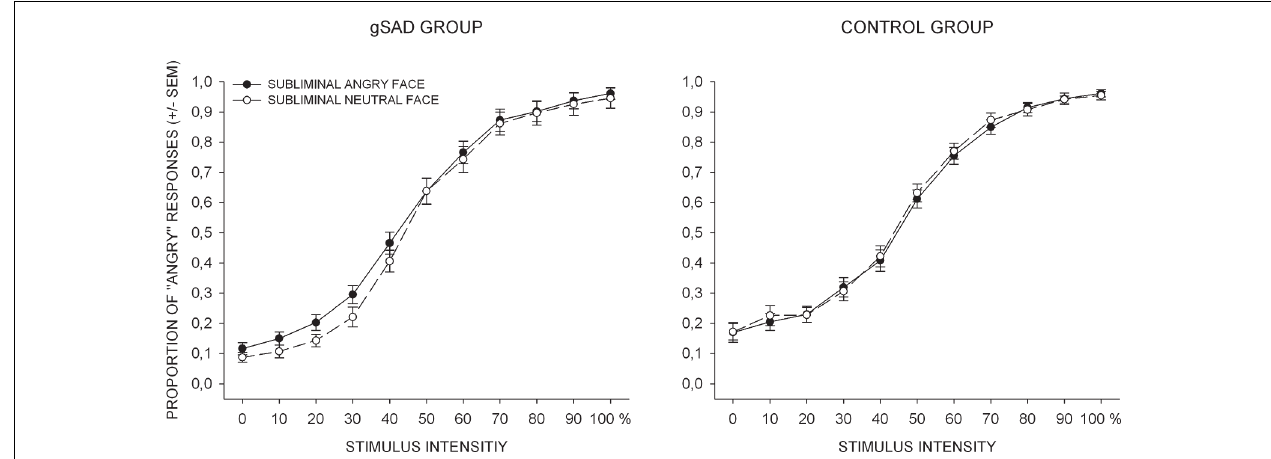
FIGURE 2 | Behavioral results for the perceptual judgment task. The percentage of “angry” responses is plotted against stimulus intensity ranging from neutral (0) to angry (100).The dark circles and solid lines represent an angry subliminal stimulus, the white circles and dashed lines represent a neutral subliminal stimulus. gSAD, generalized social anxiety disorder; SEM standard error of